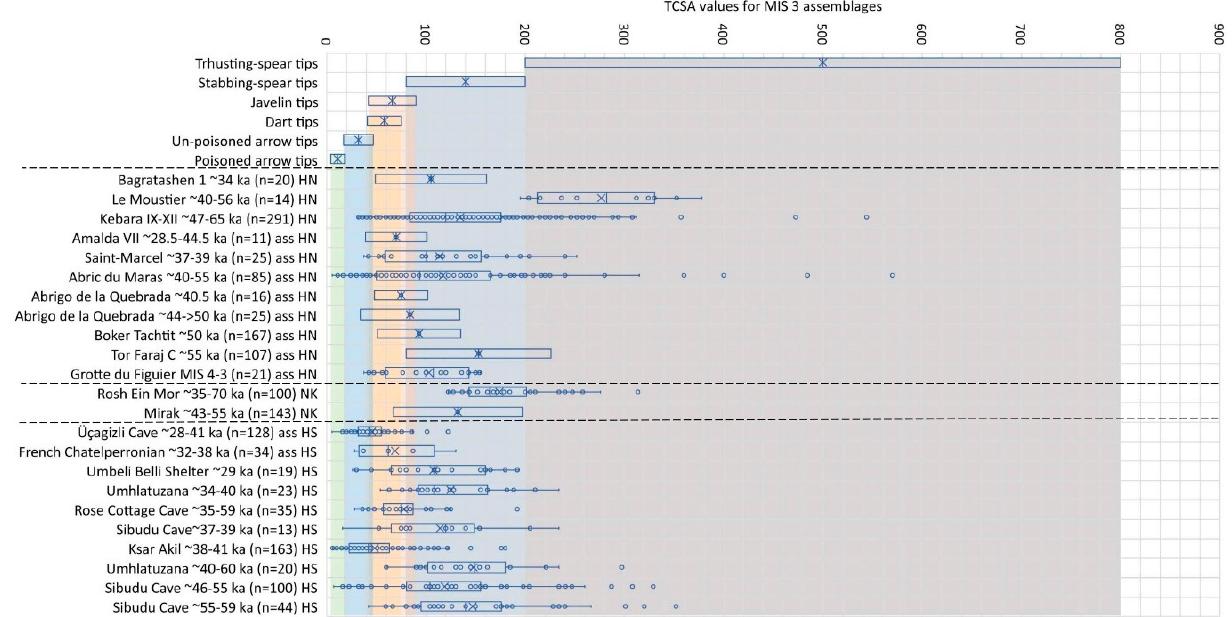
Figure 6. Comparative analysis of TCSA values for assemblages dating to MIS 3. The hominin abbreviation key is the same as for Figure 5. The key to boxplot information is the same as for Figure 2. Data sources: Bagratashen [103]; Kebara [40,41]; Amalda [98,99]; Abrigo de la Quebrada [89]; Boker Tachtit [100]; Tor Faraj [102]; Mirak [101]; Üçagizli, Chatelperonian, Ksar Akil [40]; South African assemblages